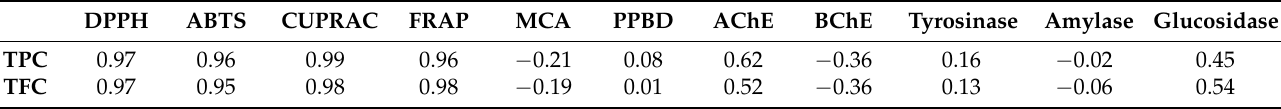
Figure 6. Exploratory multivariate analysis of the biological activities of Sartoria hedysaroides. ( A , B ): Eigenvalue and percentage of explained variances of principal components. ( C ): Circle of correlation showing the contribution of biological activities to the first two principal components. ( D ): Projection of the samples on the factorial plane PC1 vs PC2. Groups, as reported in the text, are indicated in the Figure with red circles. ( E ): Clustered Image Map (Ward linkage, Euclidean distance). Red color: high activity. Blue color: weak activity. Table 8. Relationship between total phenolics and flavonoids contents and biological activities (Pearson correlation